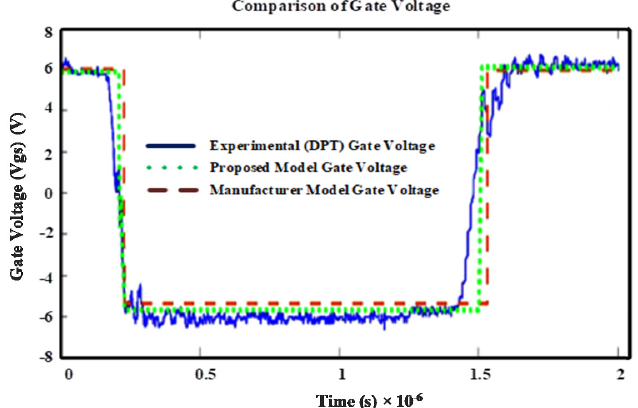
Figure 18. Comparison of gate voltage waveforms of models with DPT results.